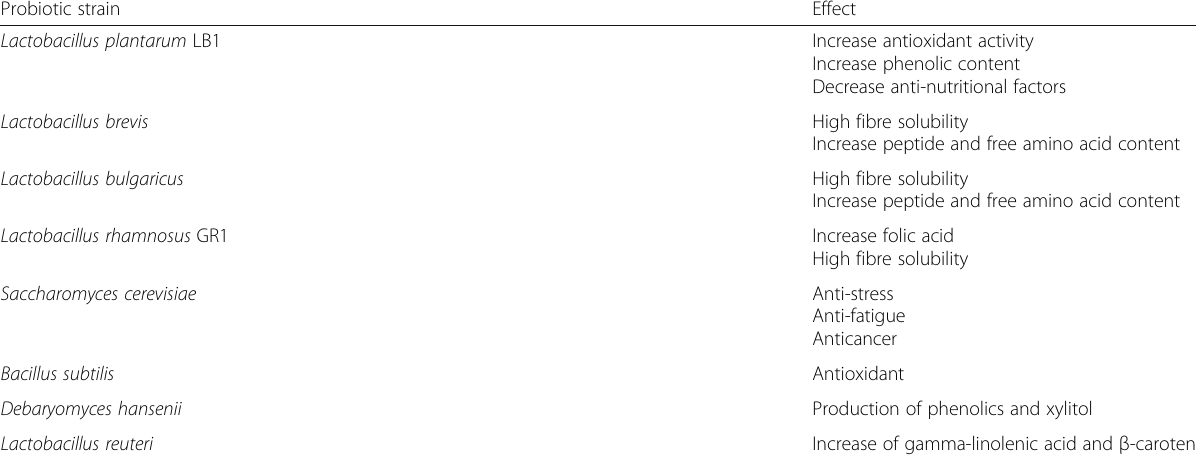
Table 3 Nutritional and functional effects of different probiotic strains on cereals and millets (Verni et al. 2019) Probiotic